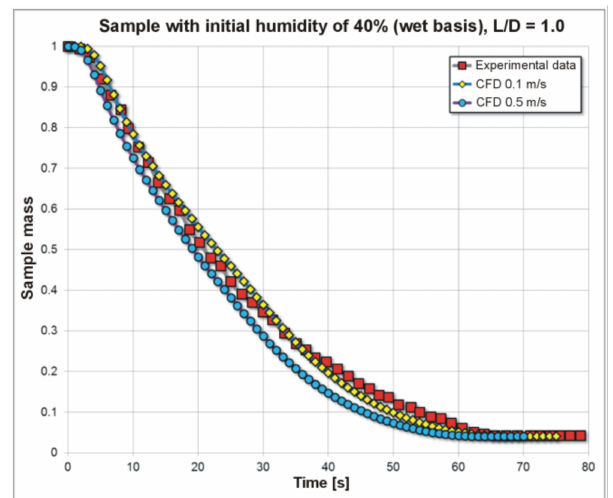
Figure 5. Comparison between simulated and experimental results [2] for pyrolysis of sample with 40% initial moisture (determined on wet basis) and L/D = 1—3D model.